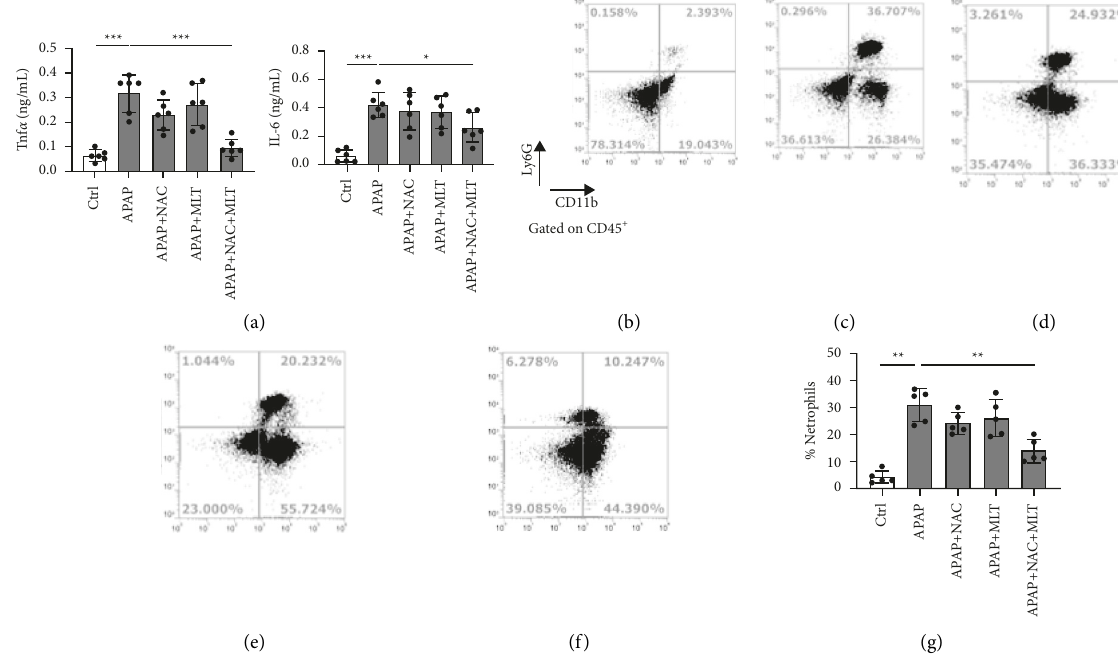
Figure 2: Enhanced inflammation resolution in mice treated with double drugs. (a) Serum levels of TNF α and IL-6 for each group. Representative FACS plots for control wild-type mice (b) ( n � 6), single APAP treated mice (c), APAP with NAC treated mice (d), APAP with MLTtreated mice (e), and APAP with two drugs (f) and statistical quantification of neutrophils in liver tissue for each group (g) ( n � 5). The columns are shown as means ± SD. ( ∗ p < 0 . 05, ∗∗ p < 0 . 01, ∗∗∗ p < 0 .